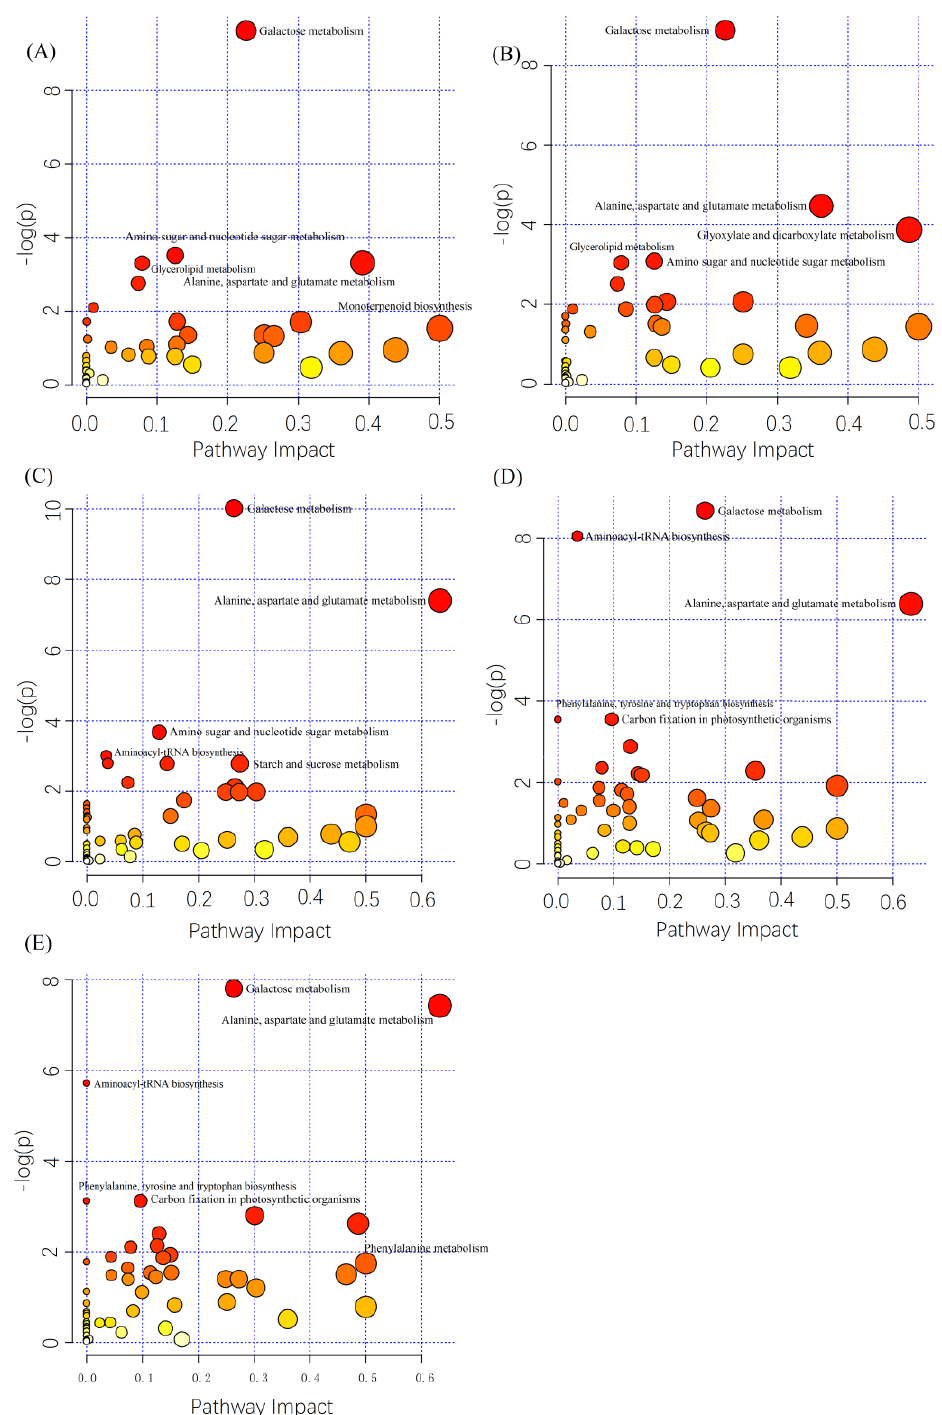
Figure 4. Pathway enrichment of differential metabolites. Pathway impact, which is an influence factor calculated from pathway topological analysis, is plotted on the abscissa, and −log ( p ), the negative logarithm of the p -value from pathway enrichment analysis, is plotted on the ordinate. Circle size is proportional to the degree of influence calculated from the topological analysis: The larger the circle, the larger the impact factor. The color of a circle reflects the negative logarithm of the p -value obtained from the enrichment analysis: The darker the color, the larger the absolute value of −log ( p ) and the more significant the enrichment. ( A – E ) Pathway enrichment during seed germination at 0.75 h ( A ), 6 h ( B ), 24 h ( C ), 48 h ( D ), and 144 h ( E ) vs. 0 h.